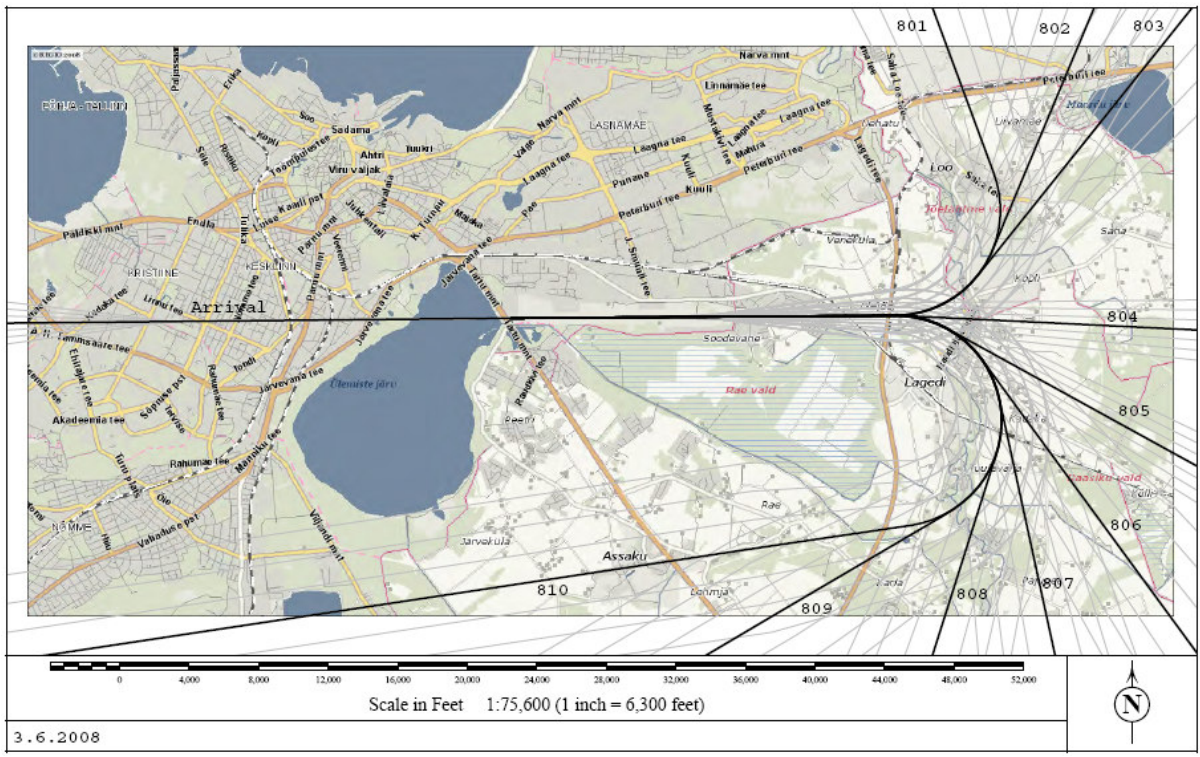
Fig 1. Tallinn Airport. Noise map according to Directive 2002/49/EC. Air corridors of runway 26